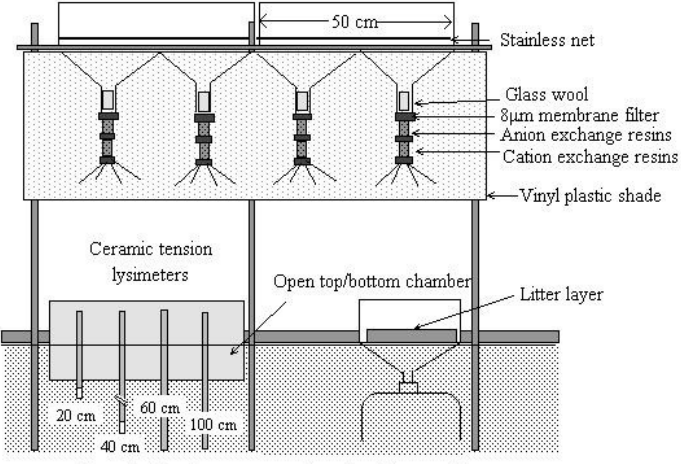
FIGURE 1 . The nitrogen removal roof and the sampling